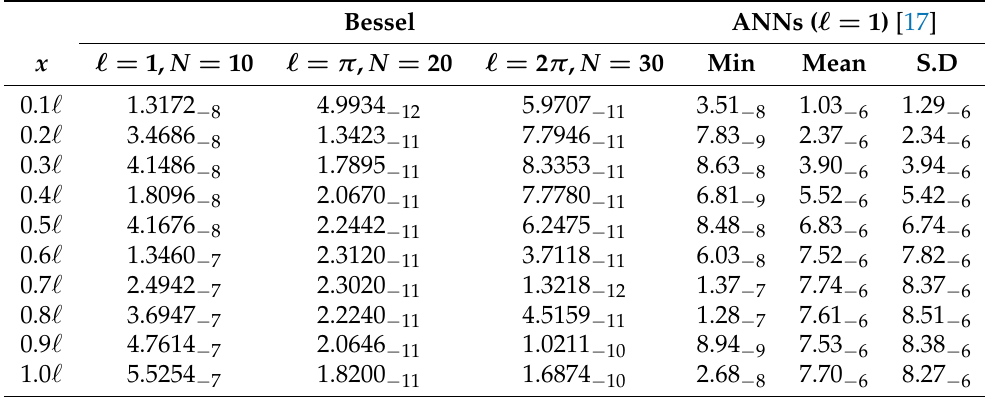
Table 3. The comparison of absolute errors in the Bessel matrix method in Example 3 utilizing N = 10,20,30, (cid:96) = 1, π ,2 π , and diverse x